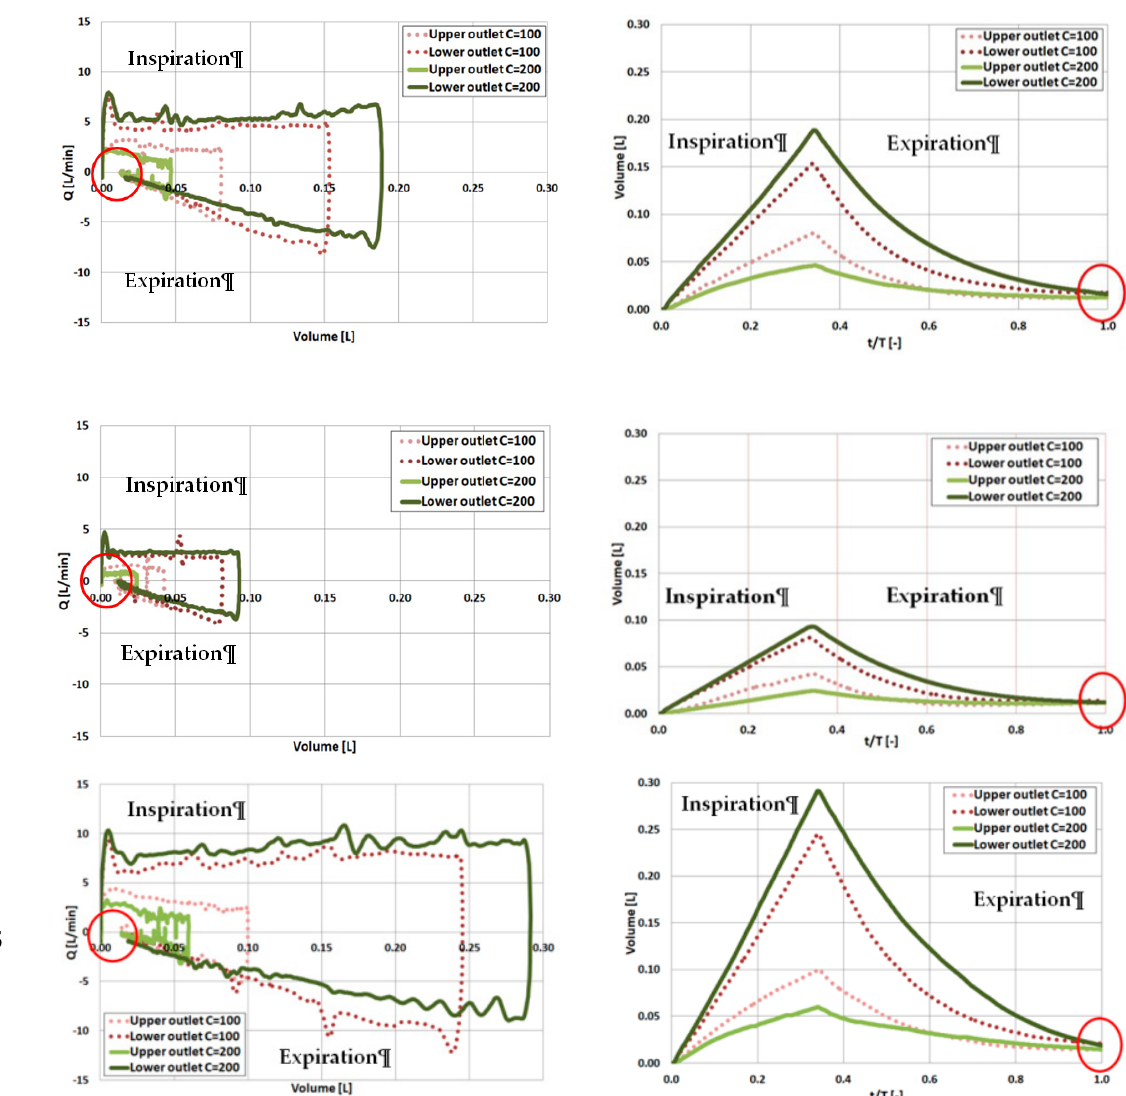
Figure 7. Flow–volume loops (Q–V) and volume–time variation (V(t/T)) during ventilation for model left lung with different system compliances (C = 100 and 200 mL/cm H 2 O) for various tidal volume divisions (lower outlet—branch with higher compliance; upper outlet—branch with lower compliance). t/T is normalized time, where t is the breath cycle time, T —is the total cycle time.